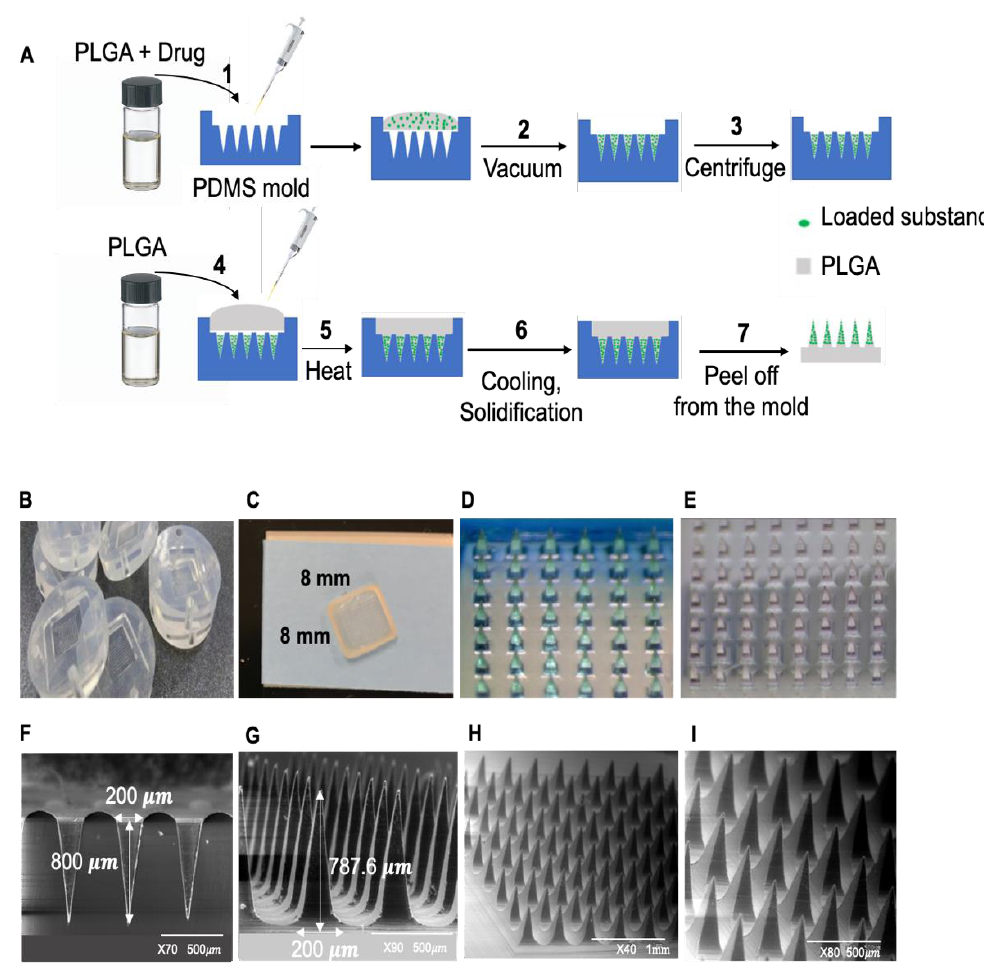
Figure 1. Microneedle fabrication and characteristics. ( A ) Schematic illustration of the process of fabricating dissolving PLGA MN patches. ( B ) MPatch microneedle mold. ( C ) Fabricated MN patch overview. ( D ) DID-loaded MN and ( E ) Rhod-PE-loaded MN. SEM micrographs of MN patches. ( F ) Length and base of the mold. ( G ) Length and base of the needles in 800 μm MN. ( H ) Intact 800 μm MN. ( I ) Intact 800 μm MN.